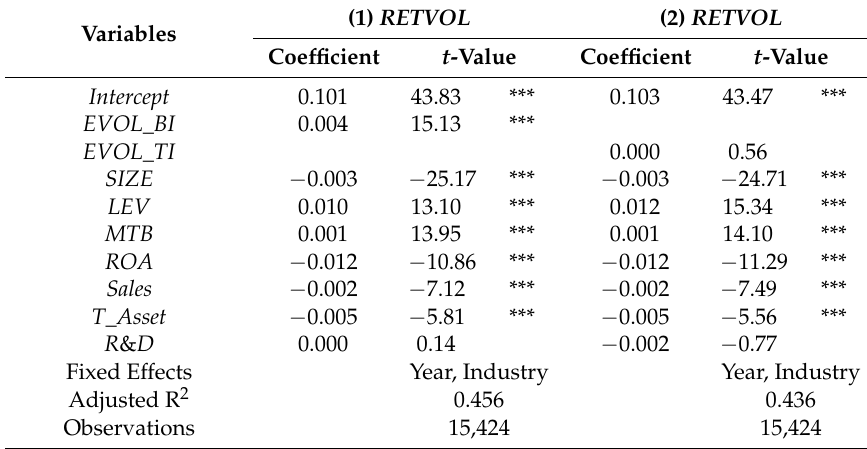
Panel B: The Collective Test for the Book Income and Taxable Income Volatilies